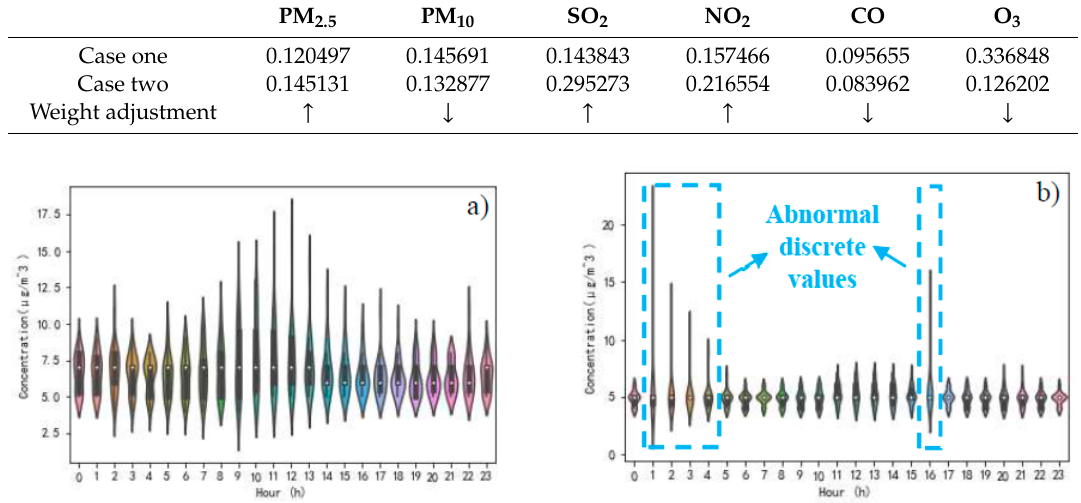
Figure 7. Time distribution characteristics of SO 2 concentration, ( a ) in case one, ( b ) in case two.